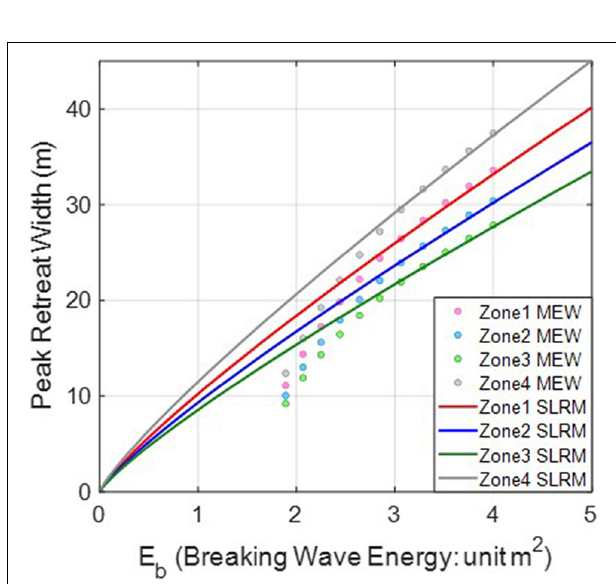
FIGURE 11 | Comparison between MEW and SLRM